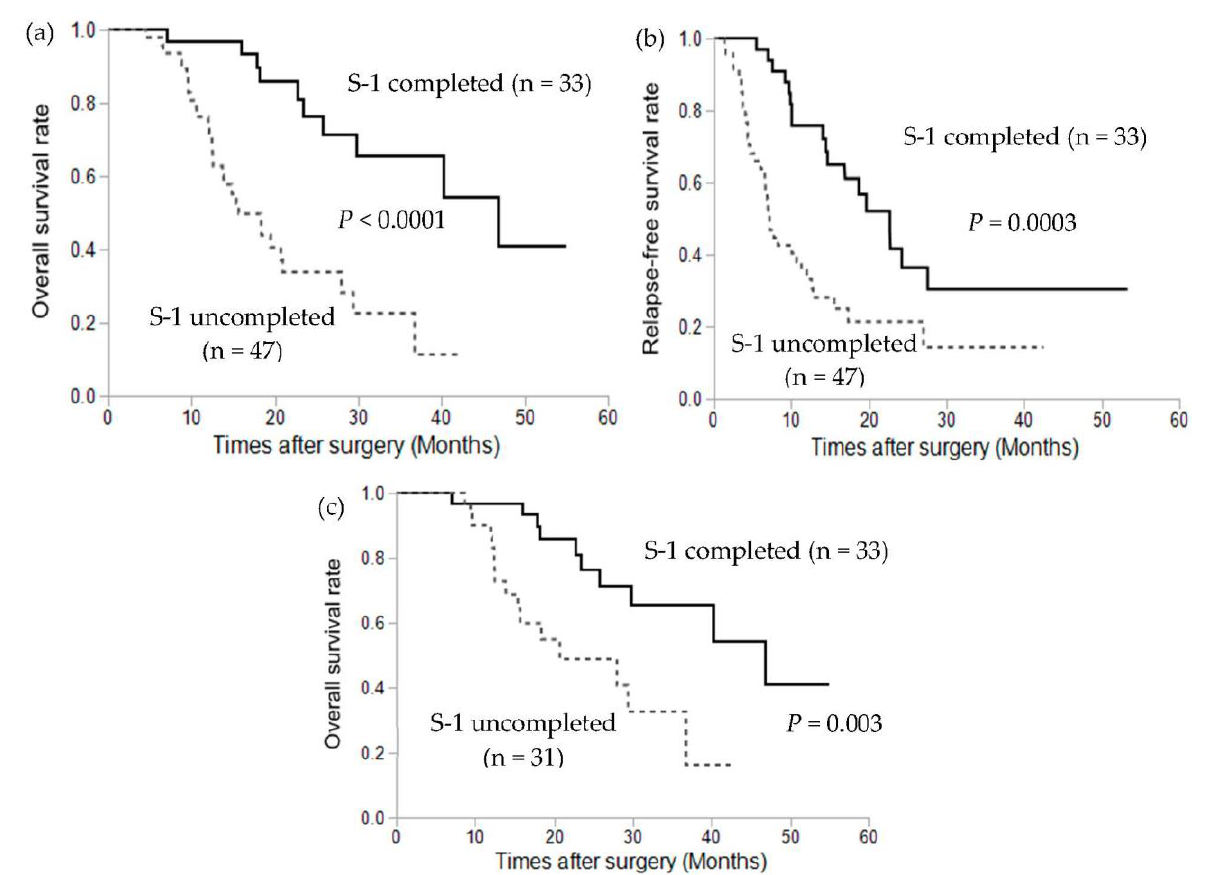
Figure 1. Kaplan – Meier plots of ( a ) overall survival, ( b ) relapse-free survival, and ( c ) overall survival of 64 patients, with the exclusion of those with recurrence during S-1 adjuvant chemotherapy.